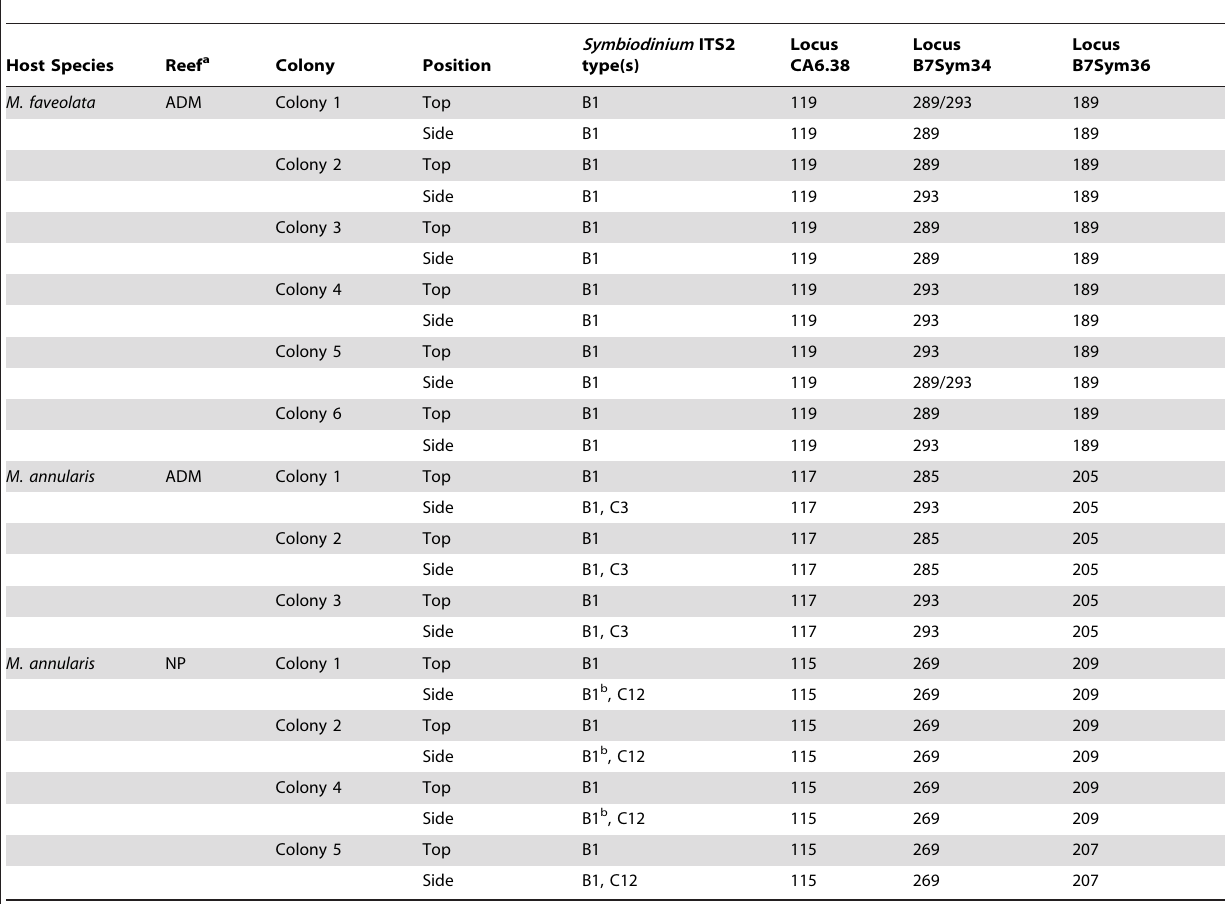
Table 3. Intracolonial variation in Symbiodinium ITS2 ‘‘types’’ and alleles of three microsatellite loci from tagged colonies of M. faveolata and M. annularis sampled in January (Exuma Cays, Bahamas) and March (Upper Florida Keys, U.S.) of 2004.